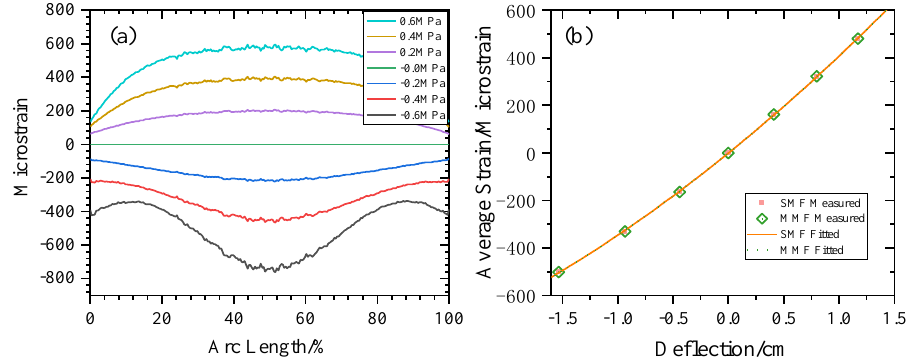
Figure 7. Relationship between winding deformation and strain. ( a ) The distribution of strain varies with the magnitude of stress. ( b ) the relationship between average stress and deflection.